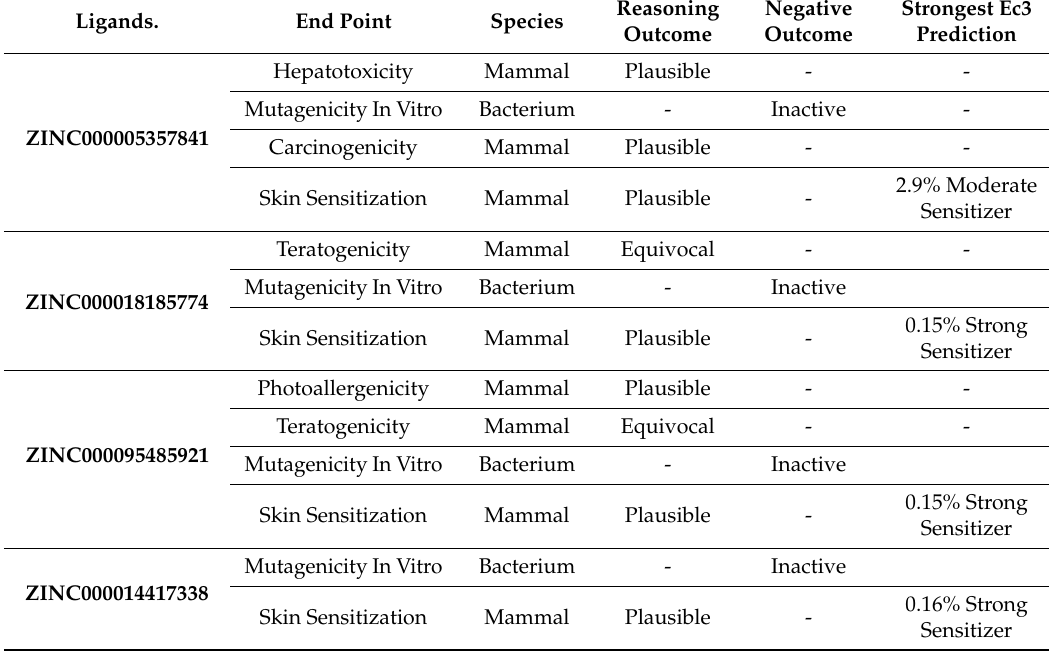
Table 6. Results obtained from Derek Nexus Software. The reasoning of outcome is indicated based on the confidence level of the predicted toxicological endpoint. The most common end point among the compounds was Skin sensitization which had a plausible outcome indicating a low confidence level.